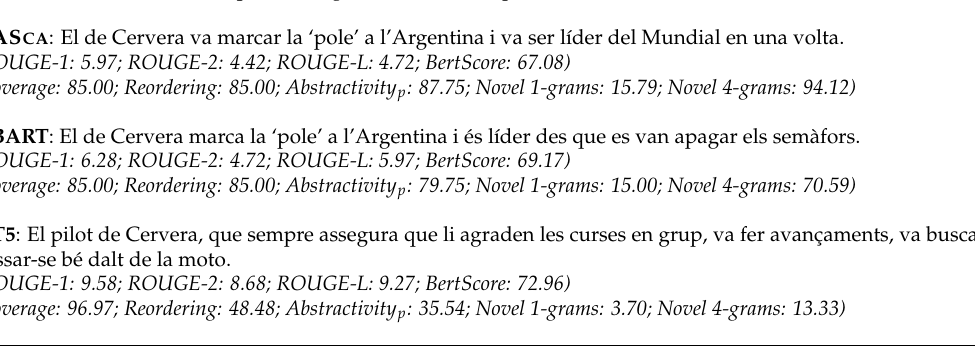
Article : La clau va ser el ritme. El ritme amb què Marc Márquez va arrencar al Gran Premi de l’Argentina i amb què el va acabar. El pilot de Cervera, que sempre assegura que li agraden les curses en grup, va fer avançaments, va buscar els forats i va passar-s’ho bé dalt de la moto: a l’Argentina va decidir ser, per un dia, infidel al seu estil. Sabia que tenia ritme, ho havia demostrat durant totes les sessions d’entrenaments lliures i també als oficials (havia dominat cinc de les sis sessions), i a la